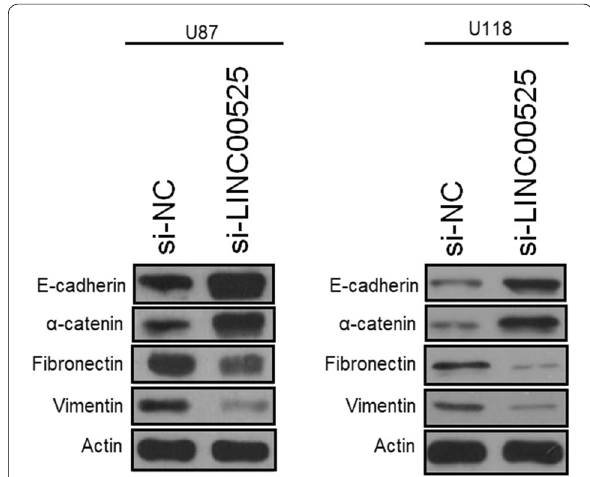
Fig. 5 Knockdown of lncRNA-LINC00525 enhances the protein expression of epithelial markers while it declines the expression of mesenchymal marker proteins. Western blotting of EMT marker proteins from U87 and U118 cancer cells transfected with si-NC or si-LINC00525. The experiments were performed in triplicate